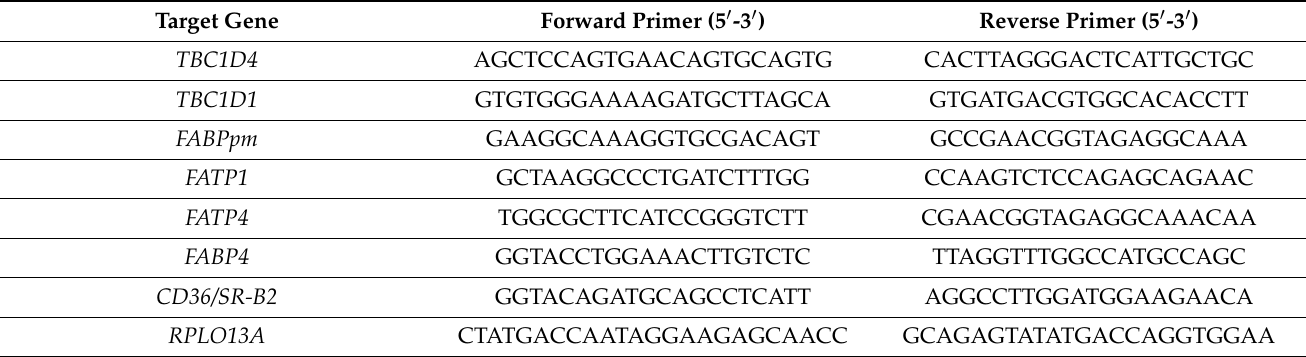
Table 1. The primers for real-time